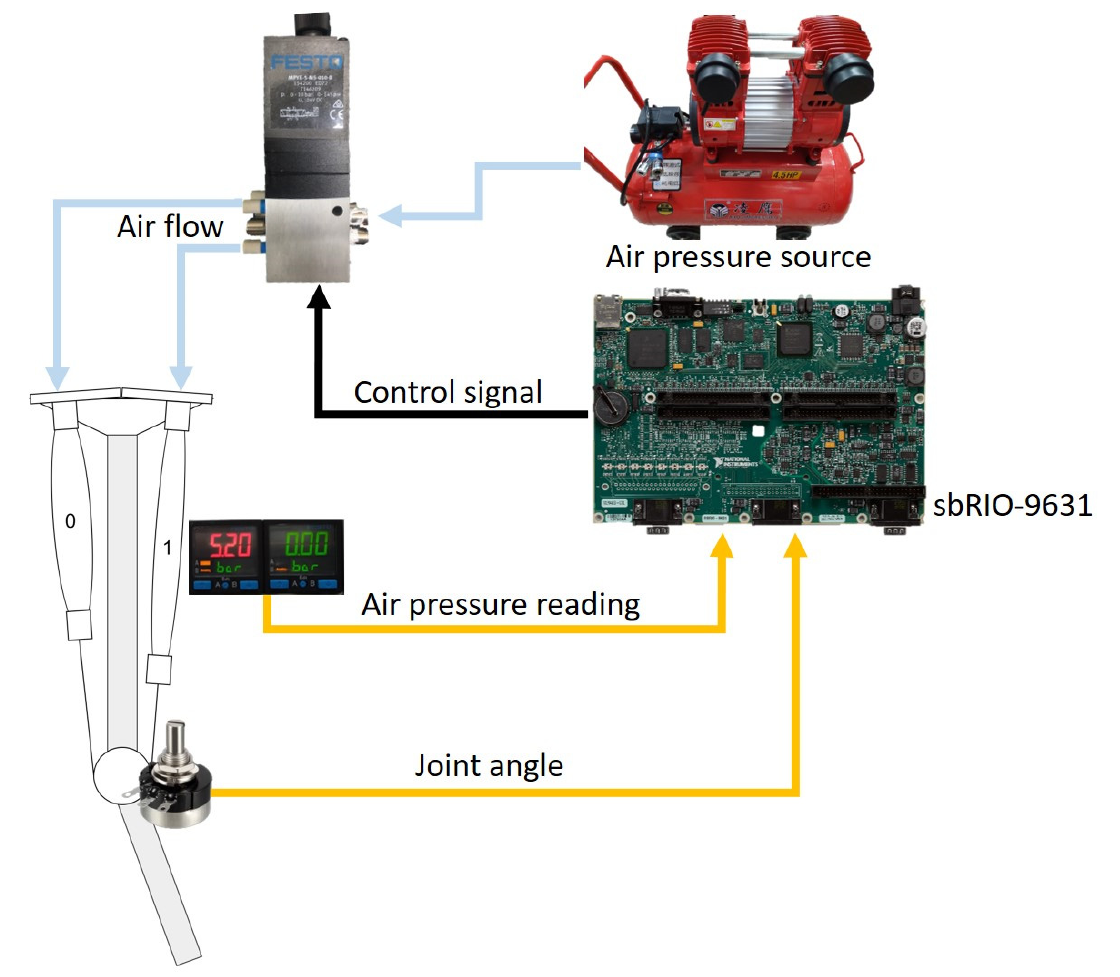
Actuators 2023 , 12 , 55 Figure 6. Knee joint control architecture. Figure 6. Knee joint control architecture.